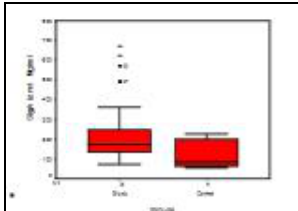
Figure 9: Salivary IgA of the study and control